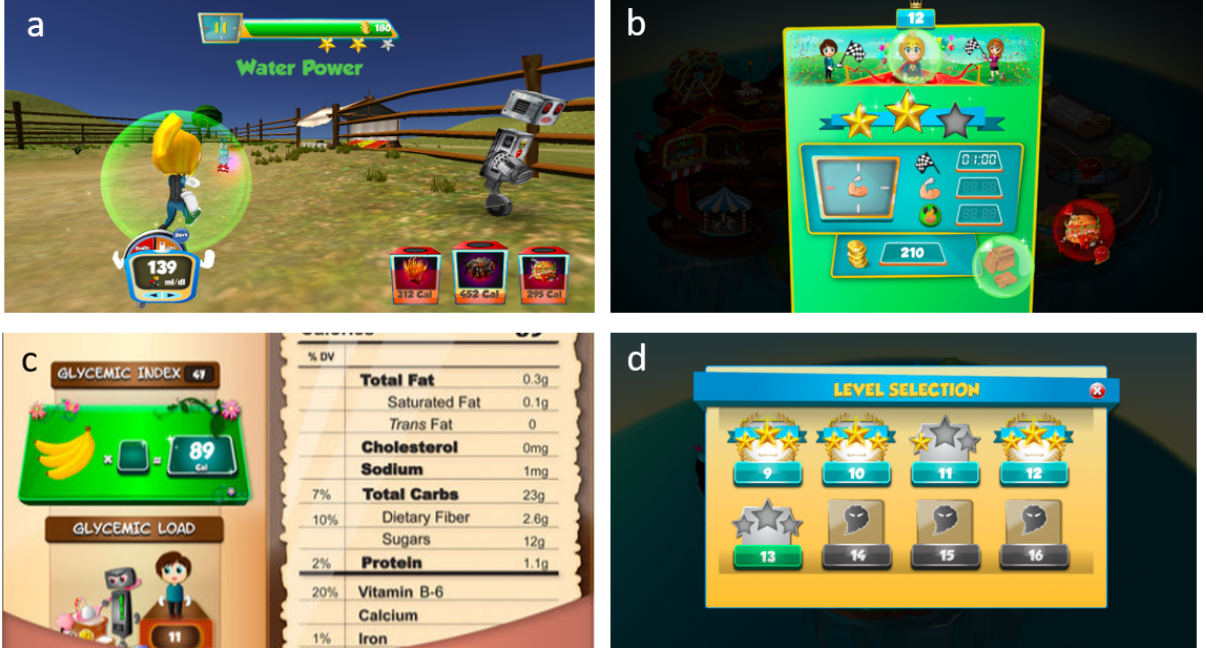
Figure 1. Screenshots of Fooya: (a) player is shielded by the bubble after consuming water, (b) performance summary after completing a level, (c) nutrition facts of a chosen food, and (d) level